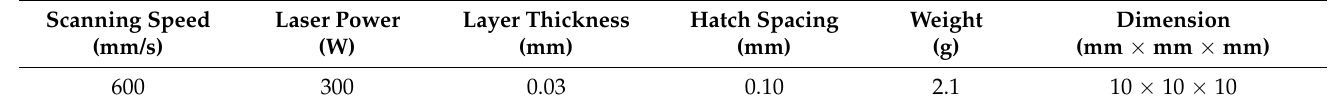
Table 2. Optimized parameters in this work and the weight and dimension of 3DHP-ZVC.